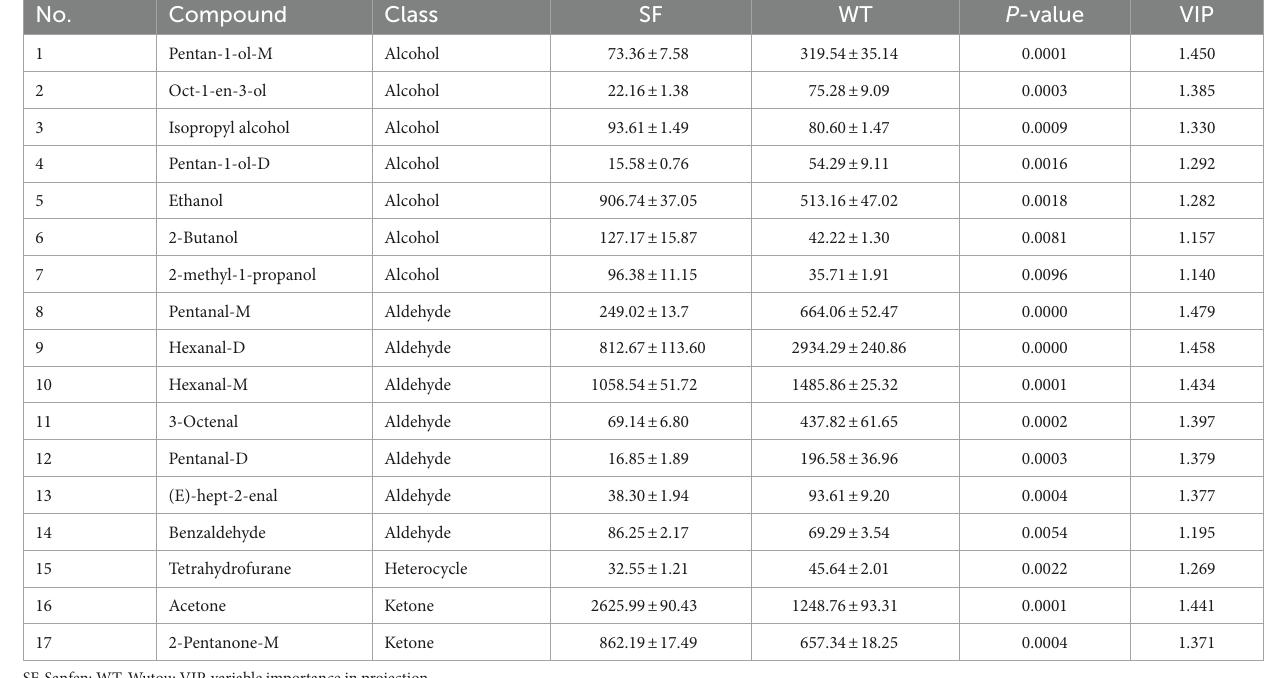
TABLE 2 Different volatile components of donkey meats from two strains (normalized intensity).